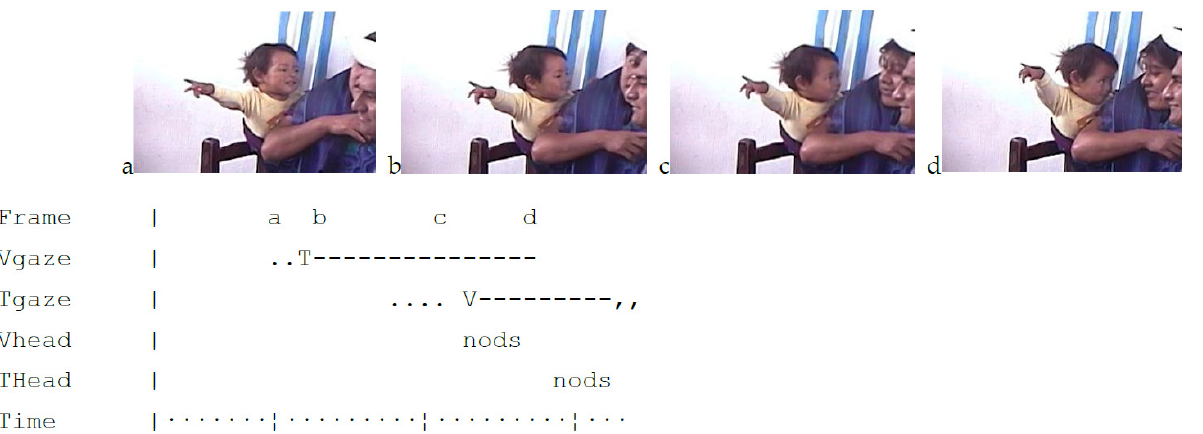
Figure 8. Vic at 12 mos. waited for Terry to engage with his pointing gesture. When Vic attempted, apparently, to mimic a pointing gesture one of the adults made, ( a ) he articulated it with a well- formed pointing hand, ( b , c ) again waited to engage Terry’s attention, then ( d ) nodded slightly at her (and received a nod in return) when she turned to meet his gaze. 10